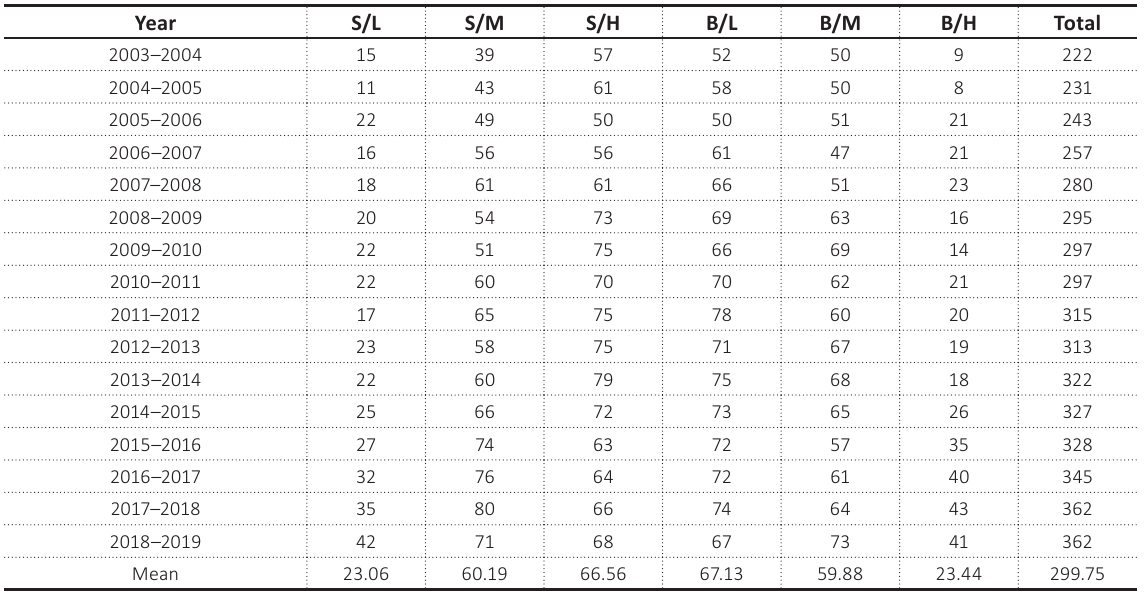
Source: Developed by the authors based on their analysis.